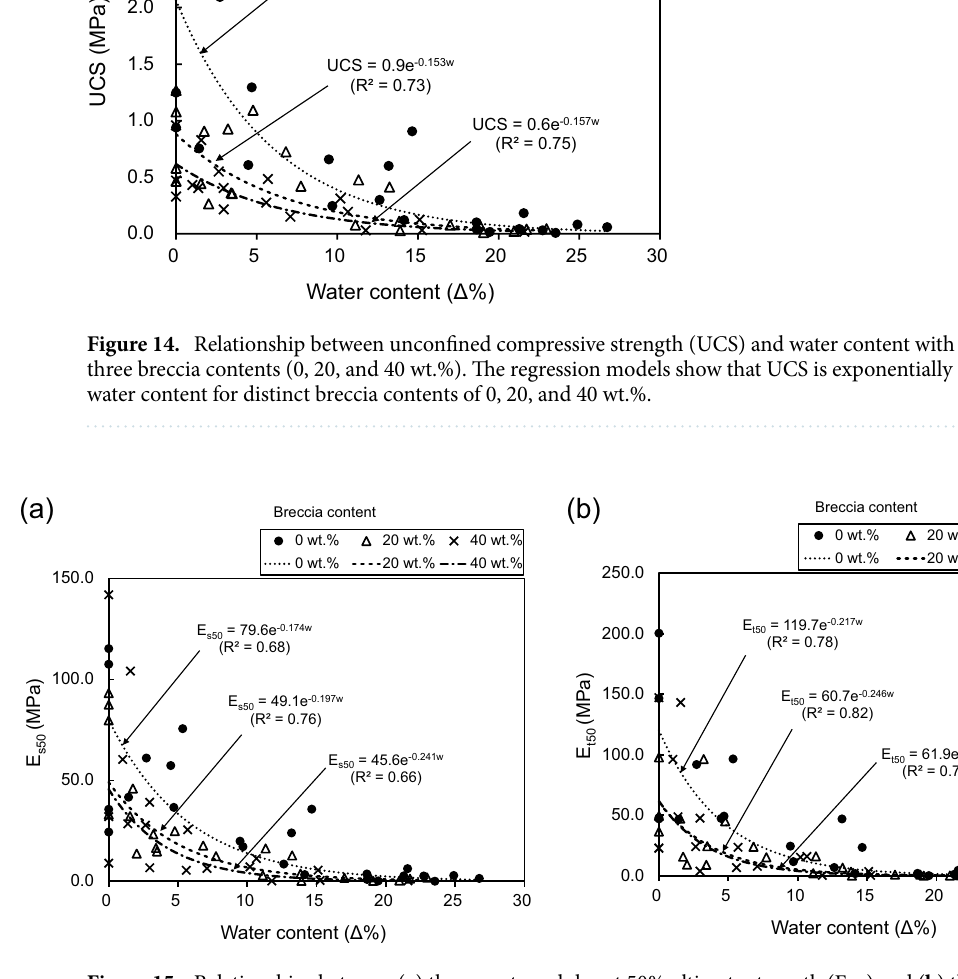
Figure 15. Relationships between ( a ) the secant modulus at 50% ultimate strength (E s50 ) and ( b ) the tangent modulus at 50% ultimate strength (E t50 ) and water content with respect to three breccia contents (0, 20, and 40 wt.%). The relationships between E s50 or E t50 are inversely related to water